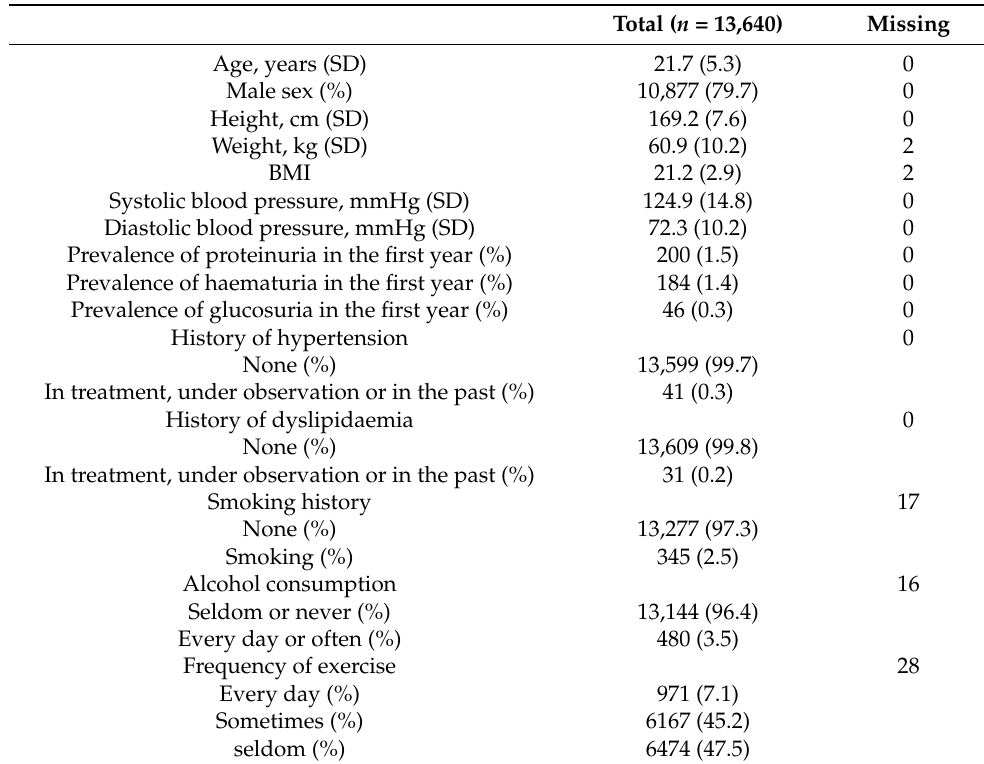
Table 1. Demographic, anthropometric, medical history and lifestyle characteristics of participants in this